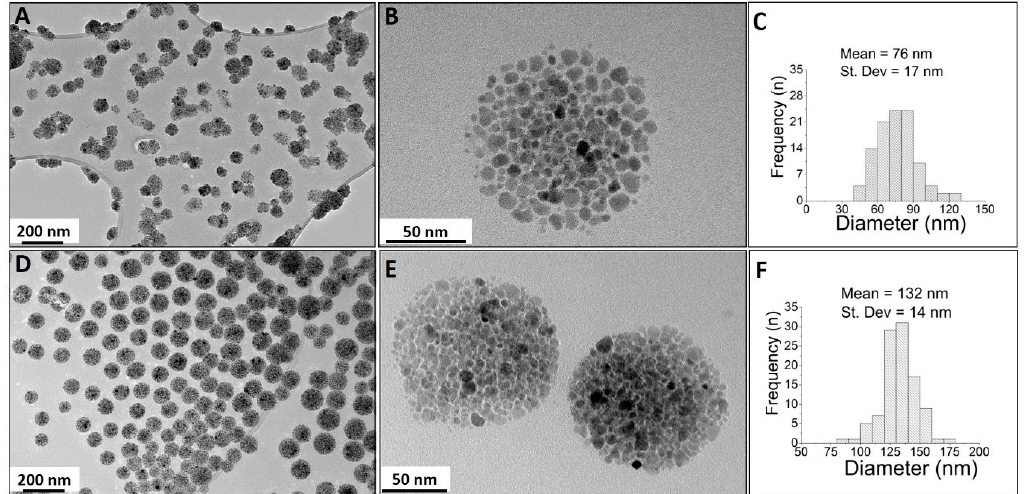
Figure 3. Transmission electron microscopy images of the magnetic multicore nanocarriers and their particle size distributions: MC-B4 ( A – C ) and MC-SP11 ( D – F ). Low ( A , D ) and high ( B , E ) magnification